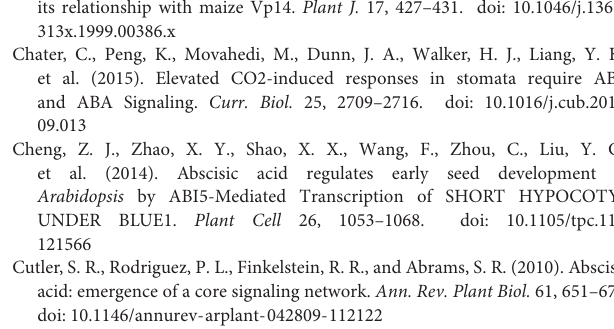
Supplementary Figure 1 | Multiple alignment of CaCYP707As amino acid sequence. Supplementary Figure 2 | CaCYP707As expression in response to drought. Supplementary Figure 3 | ABA concentration of CaCYP707As transgenic plant leaves. Supplementary Figure 4 | Dehydration phenotype of CaCYP707As transgenic plants. Supplementary Figure 5 | ABA concentration of CaCYP707A1 transgenic plant anther. Supplementary Figure 6 | Morphological patterns of CaCYP707A2, 3, and 4 transgenic plant pollen. Supplementary Figure 7 | Pollen maturation of CaCYP707A1 transgenic plant under ABA treatment. Supplementary Table 1 | A list of primer sequences used in this